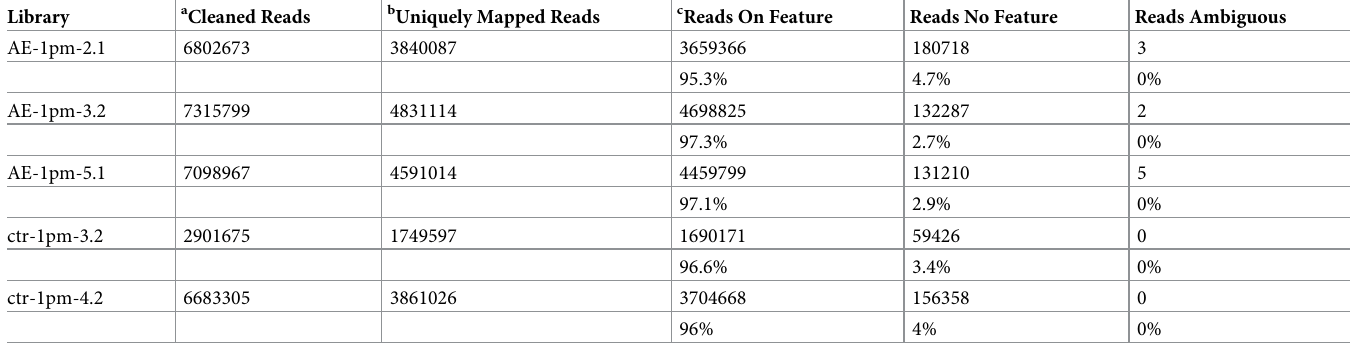
Table 1. Summary of counts for clean reads, unique mapped reads and reads on feature of miRNAs.